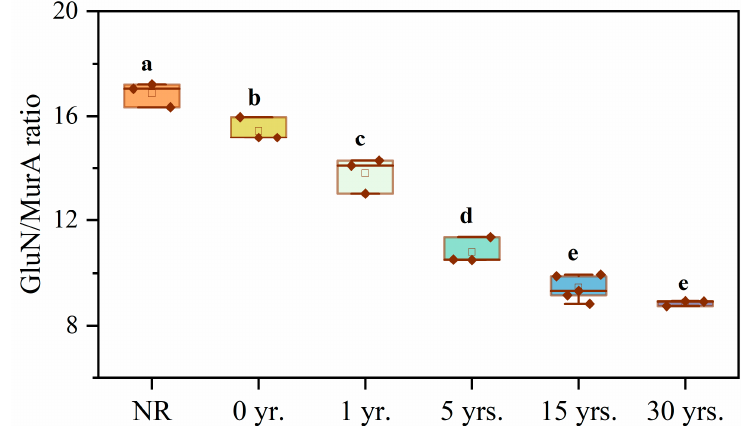
Figure 4. Ratios of glucosamine to muramic acid in soils of natural reserved land and cultivated land. Note: Different letters indicate significant difference among the land use types at p < 0.05.